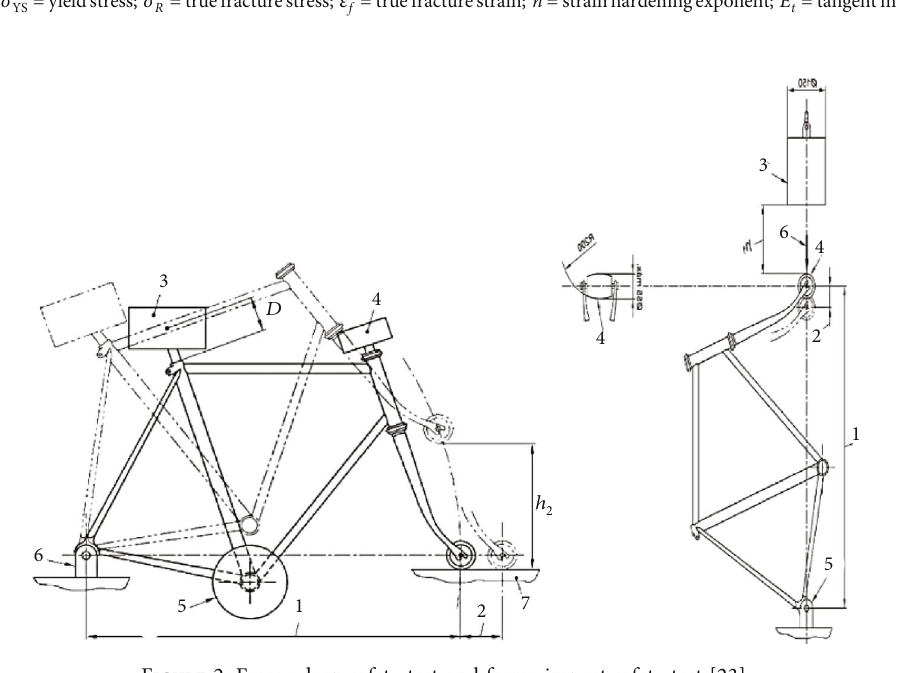
Figure 2: Frame drop safety test and frame impact safety test